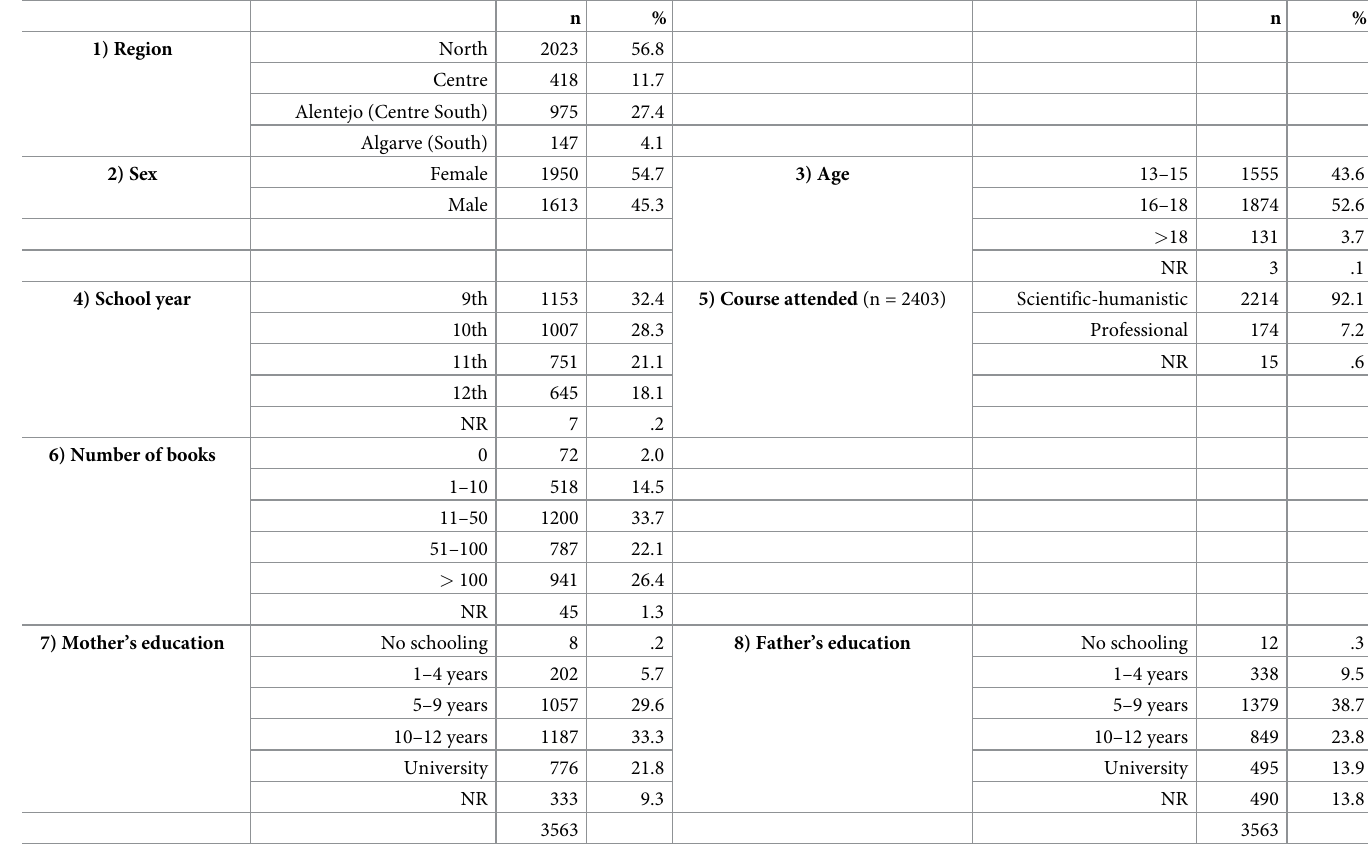
Table 1. Participants’ demographics and descriptive statistics (n =